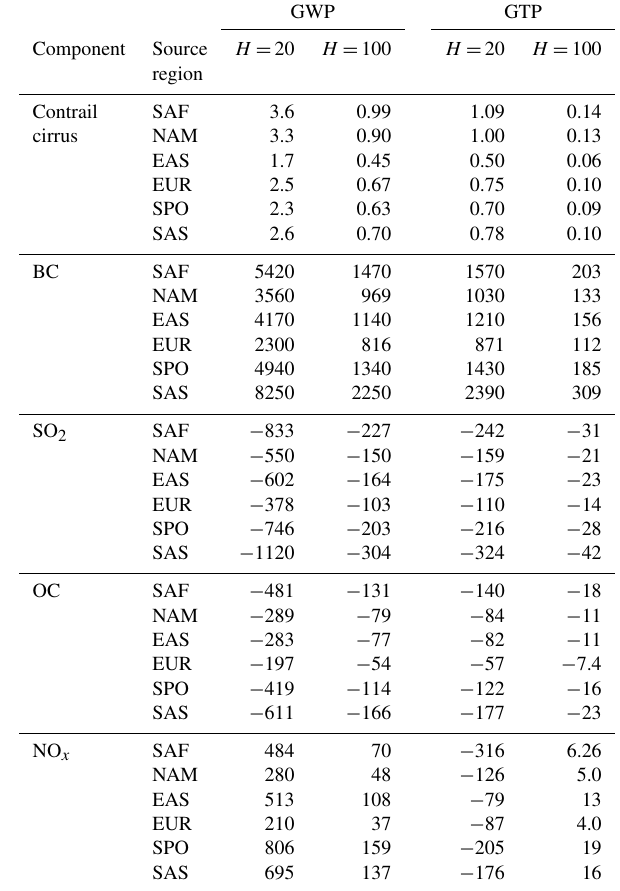
Table 2. GWP and GTP of regional aviation emissions for time horizons of 20 and 100 years. Values are given on a per unit aviation emission basis (per kgBC, OC and SO 2 , respectively, with contrail cirrus calculated per kg aviation CO 2 and NO x per